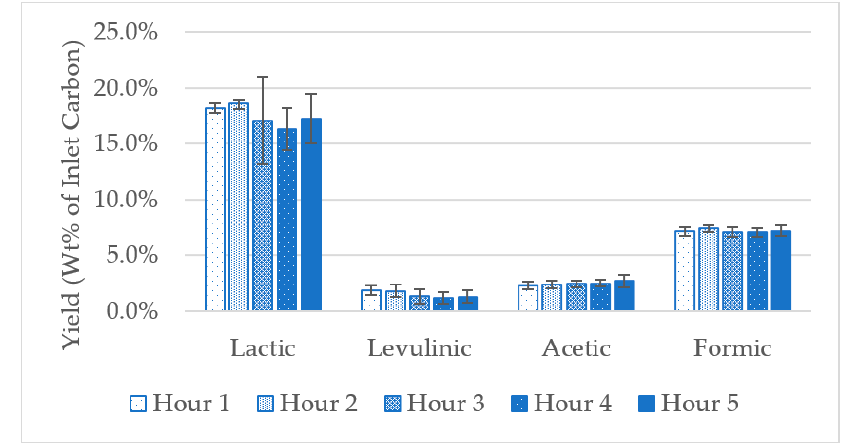
Figure 6. The effect of reaction time on organic acid yields from the Sn-Beta facilitated reaction of xylose at a reaction temperature of 200 °C, a 2:1 catalyst to sugars ratio, and no